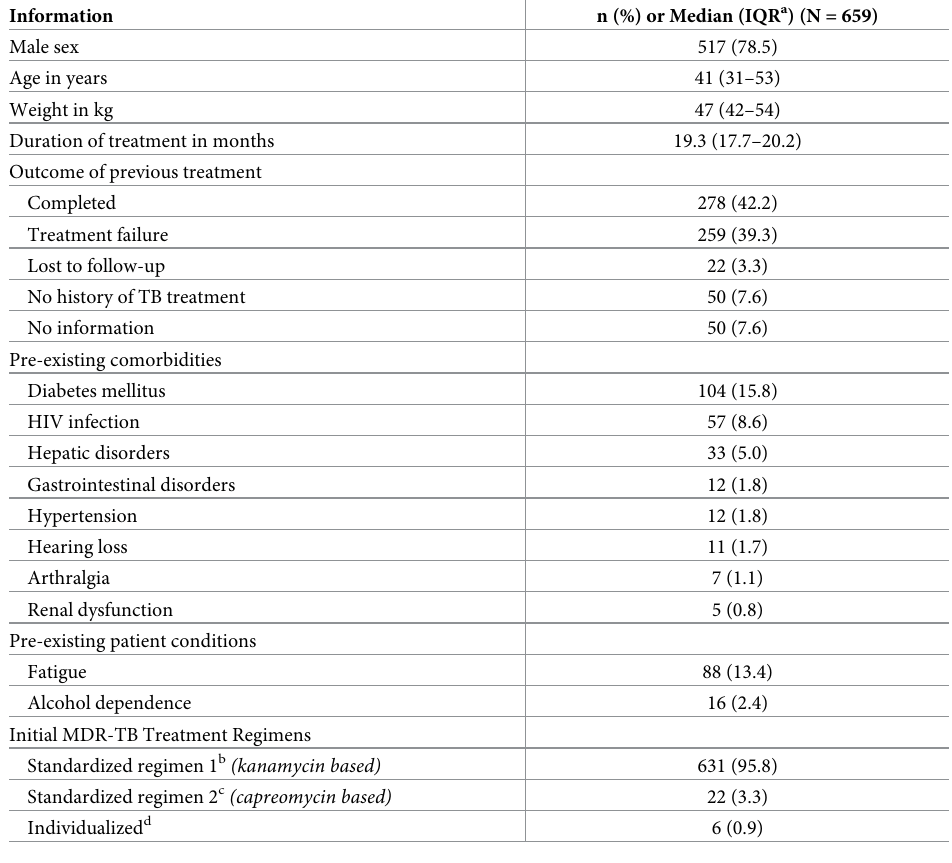
Table 1. Clinical characteristics of